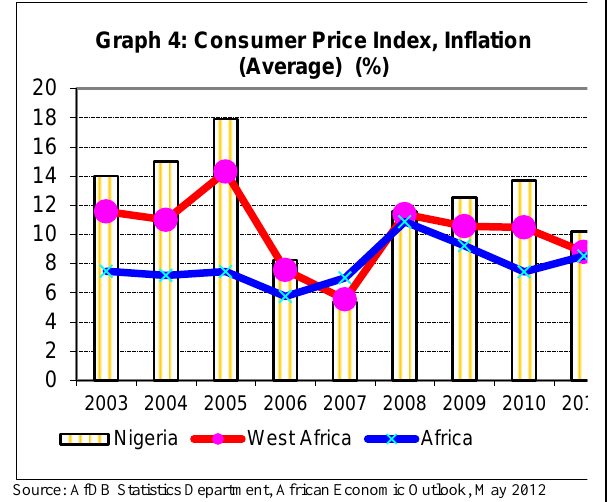
Graph 5: Current Account Balance (% of GDP): Nigeria, West Africa and Africa